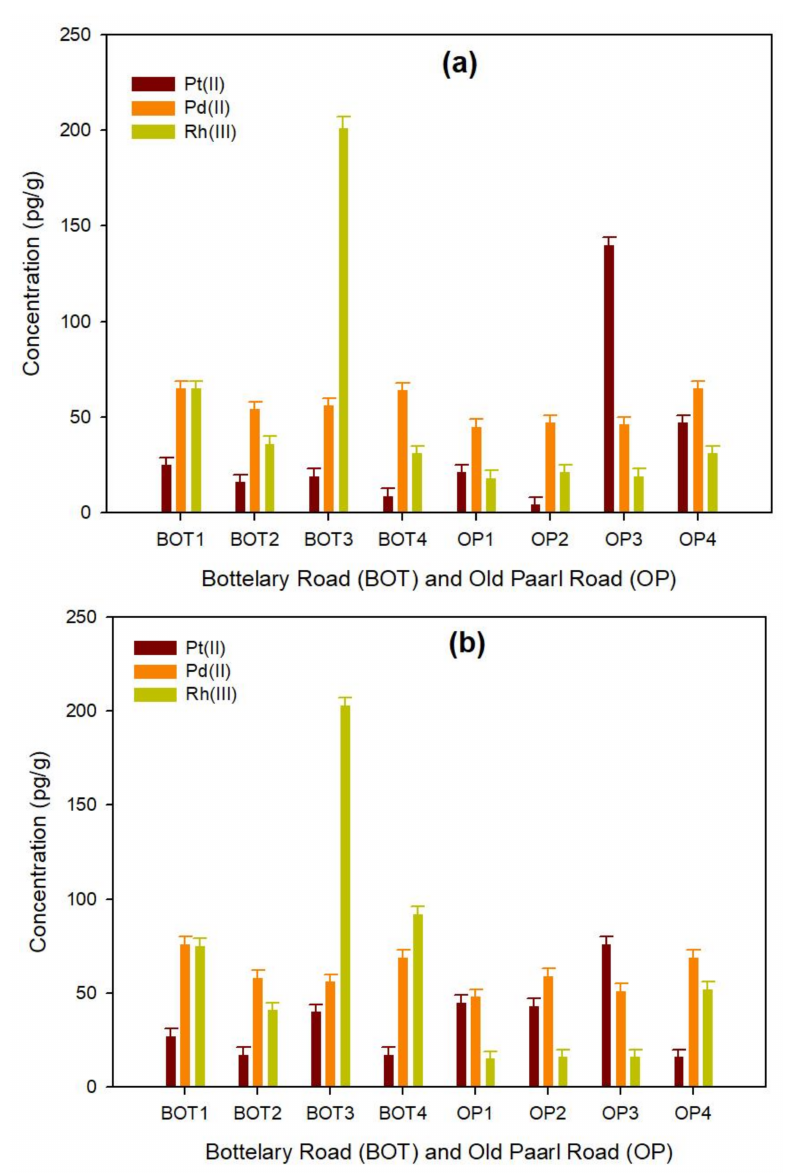
Figure 3. DPAdSV (differential pulse adsorptive stripping voltammetric) results for Pt, Pd, and Rh concentrations in road dust ( a ) and roadside soil ( b ) samples on Bottelary Road (BOT) and Old Paarl Road